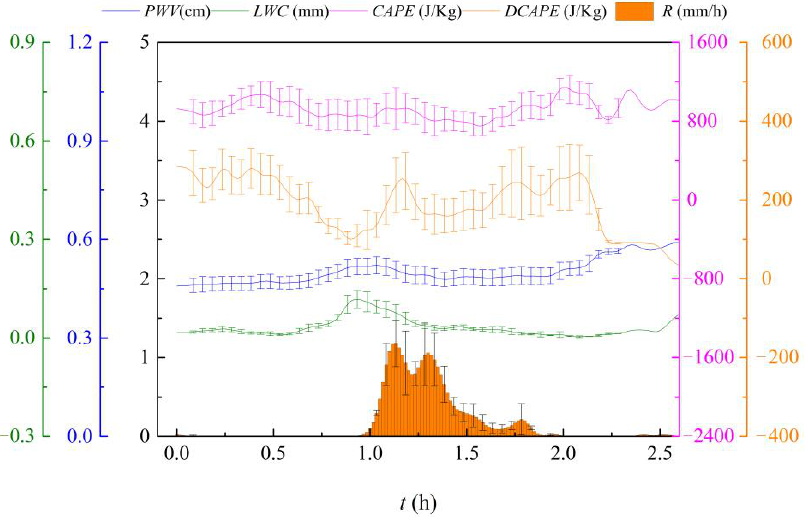
Figure 10. Temporal evolution of PWV , LWC , CAPE , DCAPE and RR for snowy days. The time instant t (h) = 0 h represents one hour before the precipitation process.